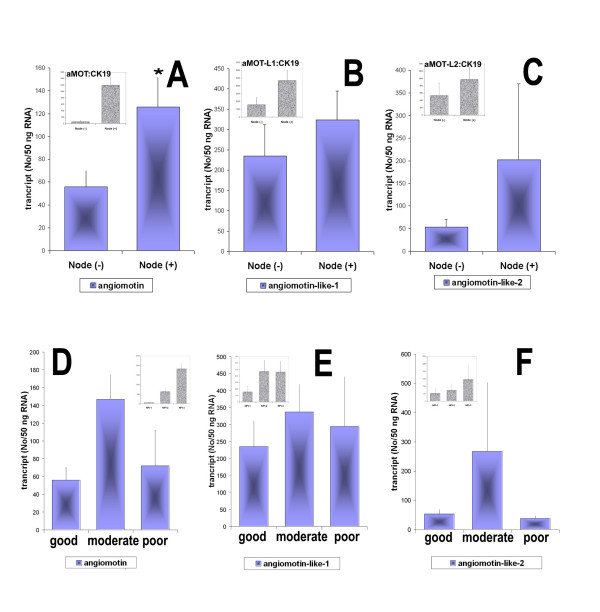
Angiomotins in nodal status (top panel, A-C) and predicted prognosis (bottom panel, E-F). A and D: angiomotin, B and E: angiomotin-like-1, C and F: angiomotin-like-2. A, B AND C : difference between node negative and node positive tumours. * p < 0.01 vs node negative tumours. D, E &F: angiomotins and predicted clinical outcome based on Nottingham Prognostic Index (NPI = (0.2 × size) + grade + Nodal status). NPI<3.4, 3.4–5.4 and >5.4 represented good (15 year survival rate 80%) (NPI1), moderate (15 year survival 42%) (NPI2) and poor prognosis (15 year survival 15%). Inserts: respective angiomotin transcript:CK19 transcript ratio.